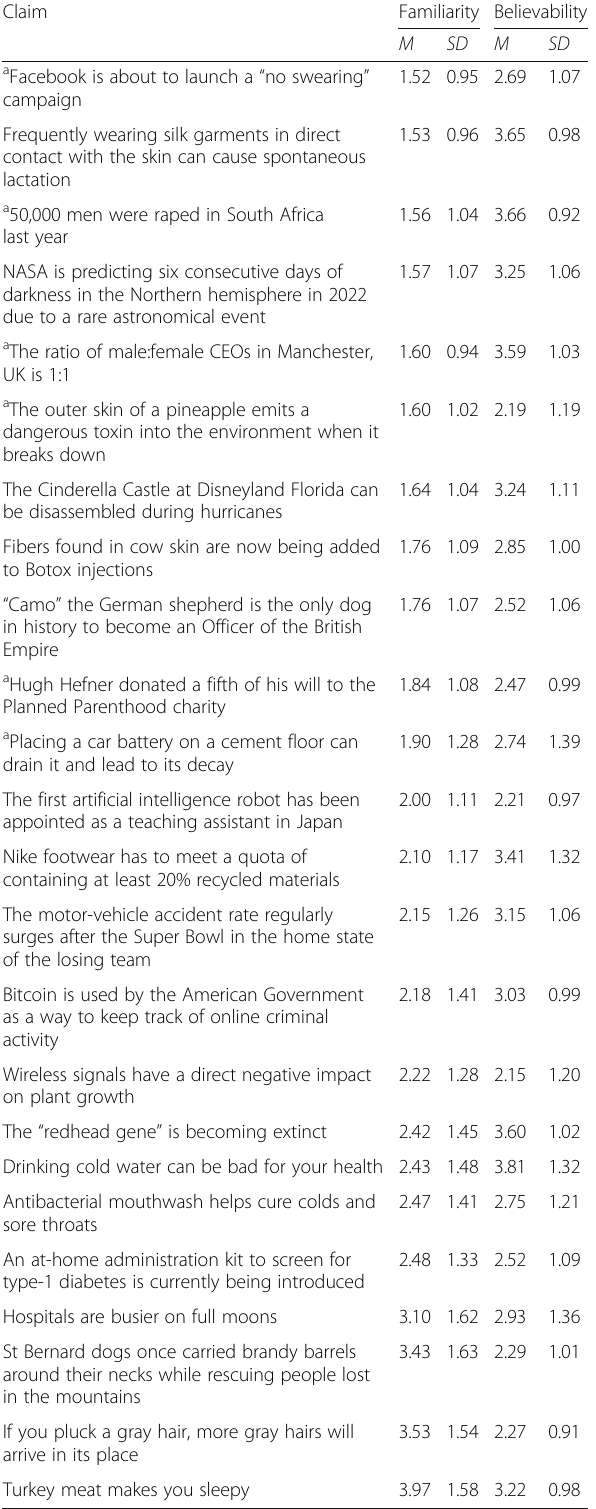
Table 5 Familiarity and believability ratings of false claims